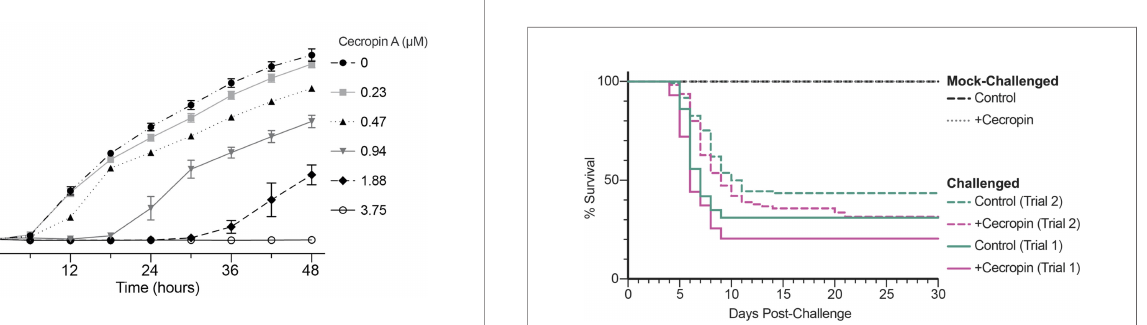
FIGURE 1 | Dose-dependent inhibition of Y. ruckeri by cecropin A in vitro . Y. ruckeri was incubated at 16°C in broth supplemented with serial dilutions of cecropin A. The experiment was performed in a 96-well plate and OD 600 was recorded in triplicate wells per sample for a period of 48 hours. Plotted values are the average of three independent experiments. No change in OD 600 was observed in wells containing 3.75, 7.5, and 15 µM cecropin A (latter two concentrations not shown).